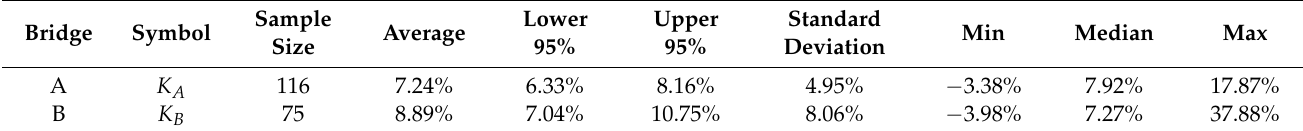
Figure 12. Frequency histogram of 𝐾 (cid:3036) of each cross-section of bridge A and bridge B, ( a ) bridge A, ( b ) bridge B.